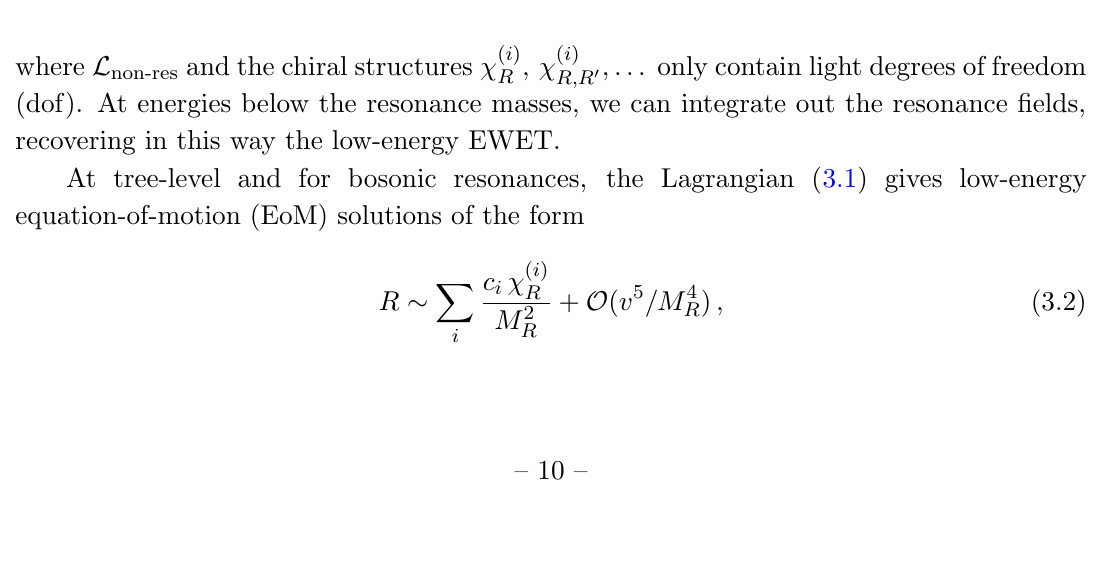
Table 2 . CP -invariant and P -odd operators of the O ( p 4 ) EWET Lagrangian. The left column shows bosonic, the central two-fermion, and the right column four-fermion operators. All Wilson coe(cid:14)cients are Higgs-dependent